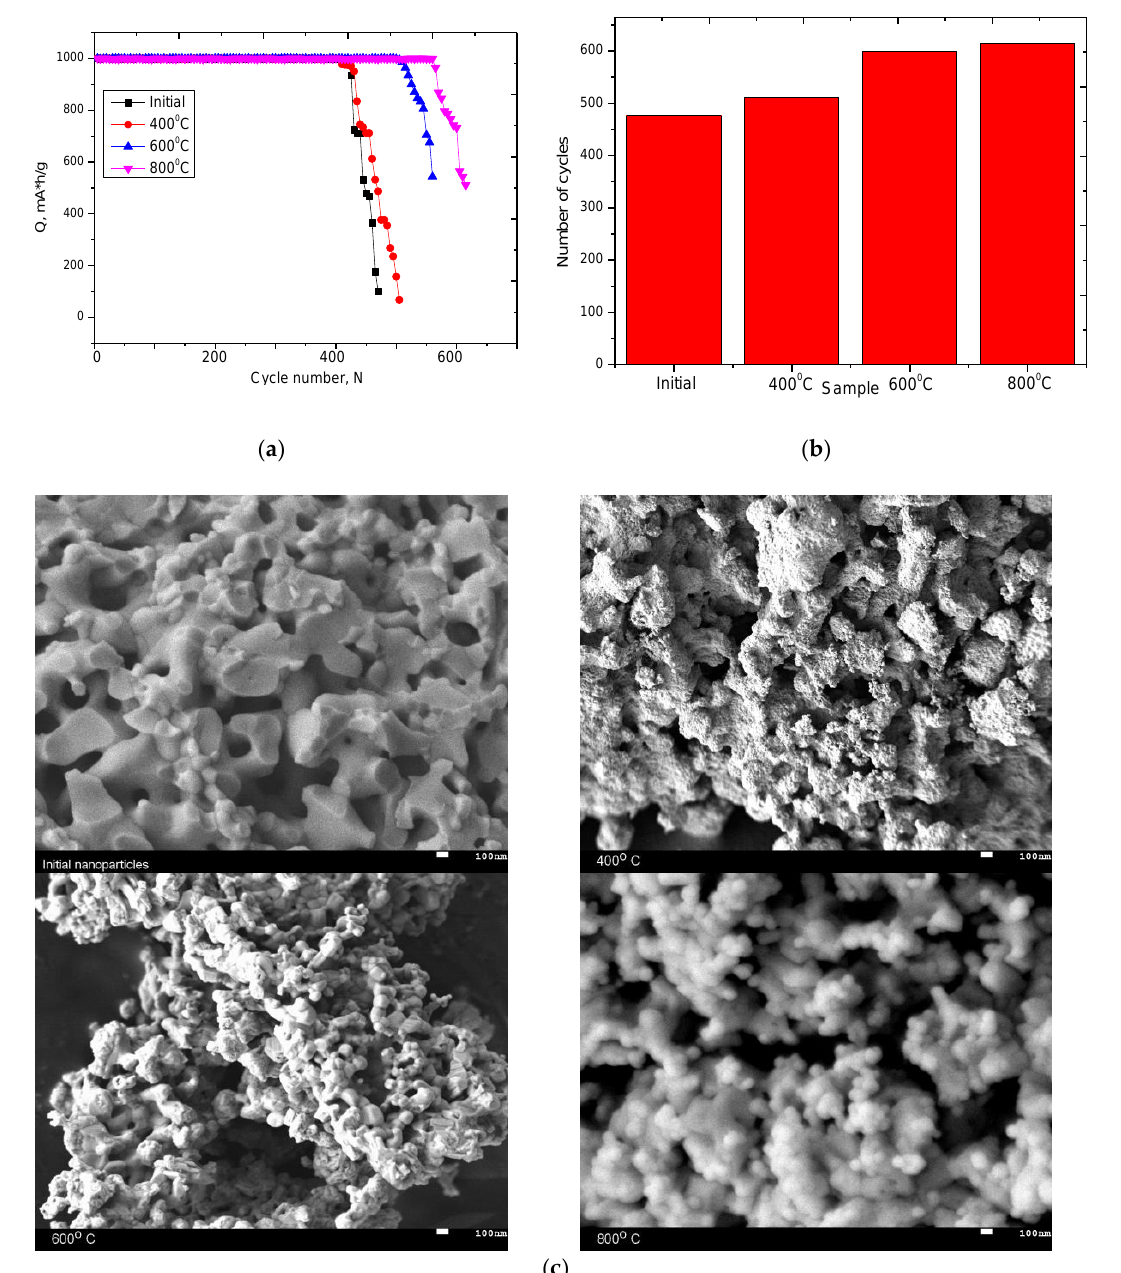
Figure 9. ( a ) Graph of specific discharge capacity versus the number of cycles tested in charge capacity mode 1000 mA h/g; ( b ) graph of the lifetime of nanoparticles on the type of modification (before degradation begins and capacity decreases below 80%); ( c ) SEM images of the studied nanoparticles after life tests.